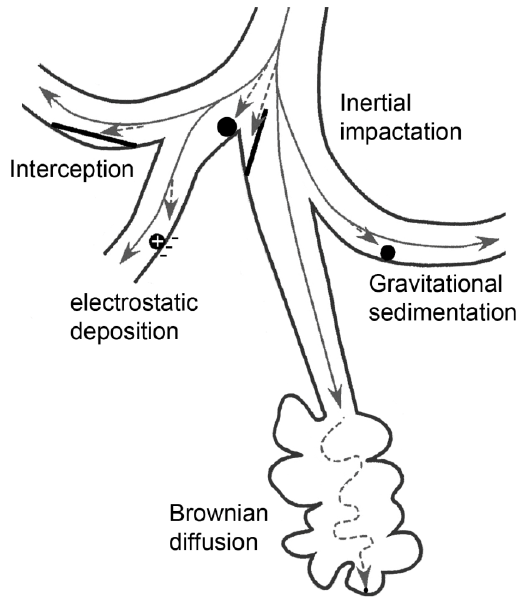
Figure 6. Particle parameters important for deposition in the whole lung. Large particles are subjected to inertial impactation, preferentially in large airways, smaller particles deposit by gravitational sedimentation, and small particles in the alveoli by diffusion. Electrostatic deposition is seen for charged particles and interception for fiber-shaped